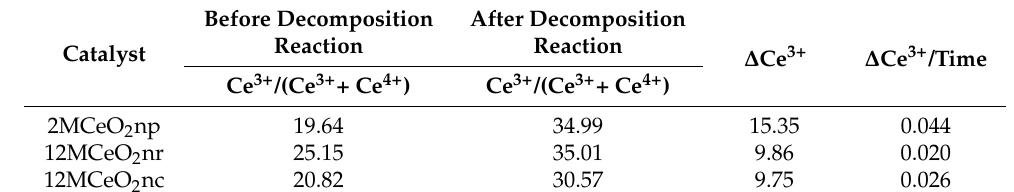
Table 4. Variation of Ce 3+ content in clean and deactivated catalysts. Before Decomposition After Decomposition Reaction Reaction Catalyst